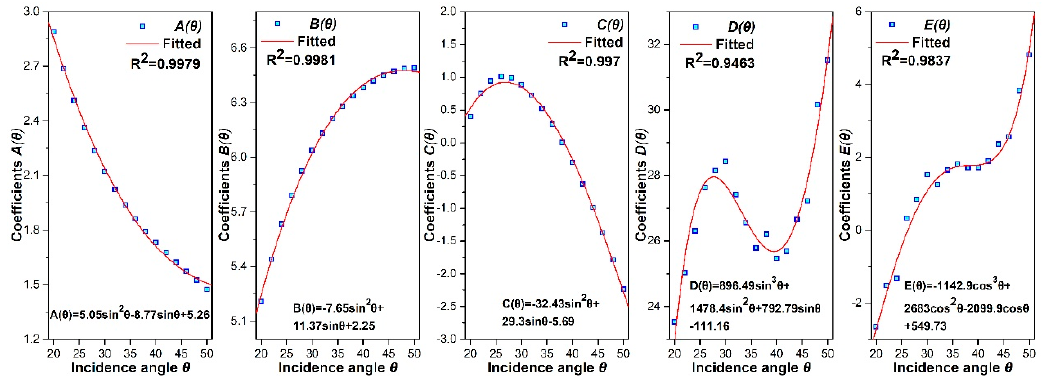
Figure 9. Response of the incidence angle 𝜃 to the function coefficients: 𝐴(𝜃) , 𝐵(𝜃) , 𝐶(𝜃) , 𝐷(𝜃) , 𝐸(𝜃) , while the red curve represents the fitted function.